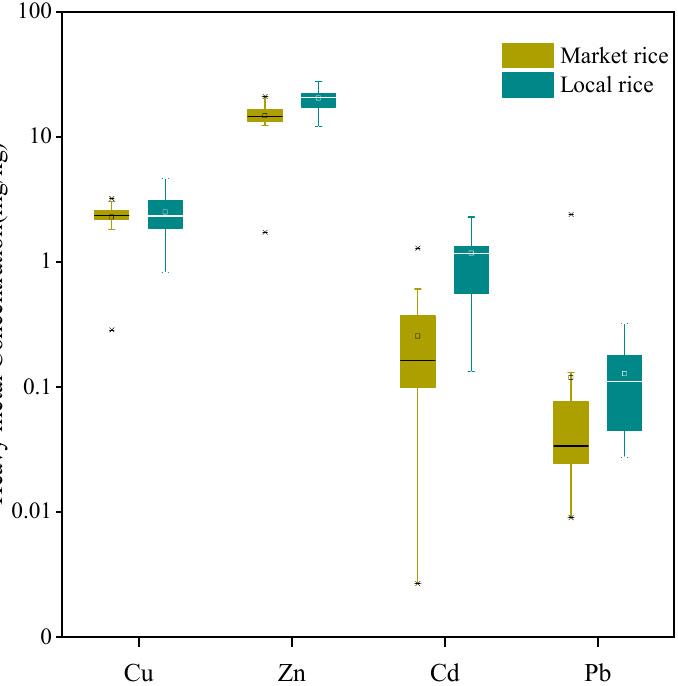
Figure 2. Box plots of heavy metal concentrations in rice (dry weight). Middle band, box and whiskers represent the median, 25th and 75th percentile and 5th and 95th percentile, respectively. Squares represent means, whereas ‘‘*’’ represent extreme values.